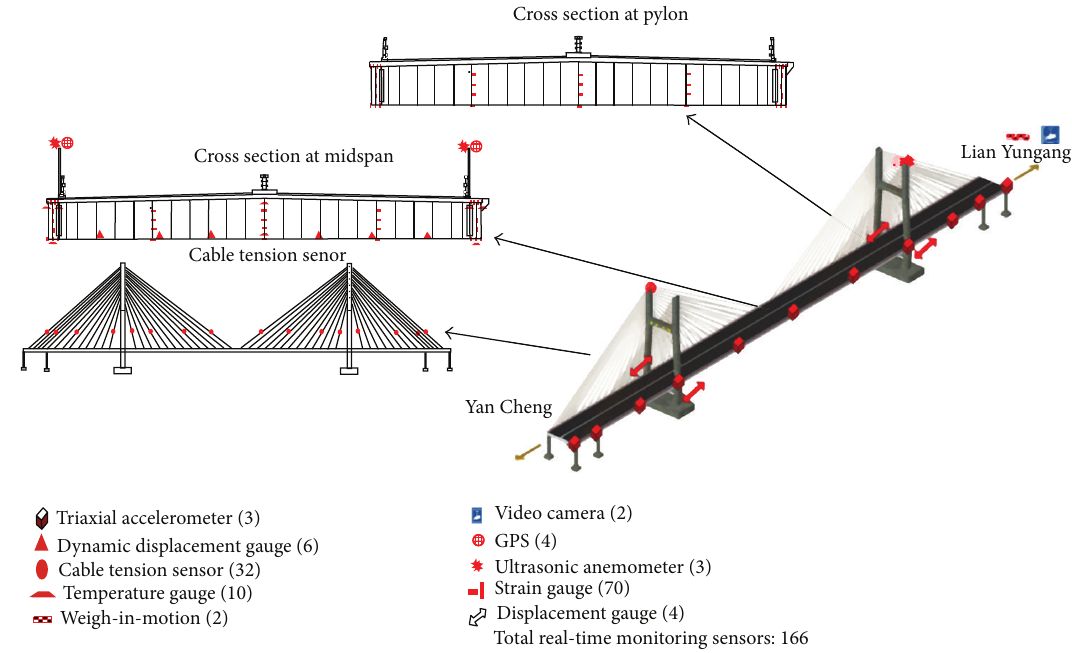
Figure 5: Sensors setting of SHM system.